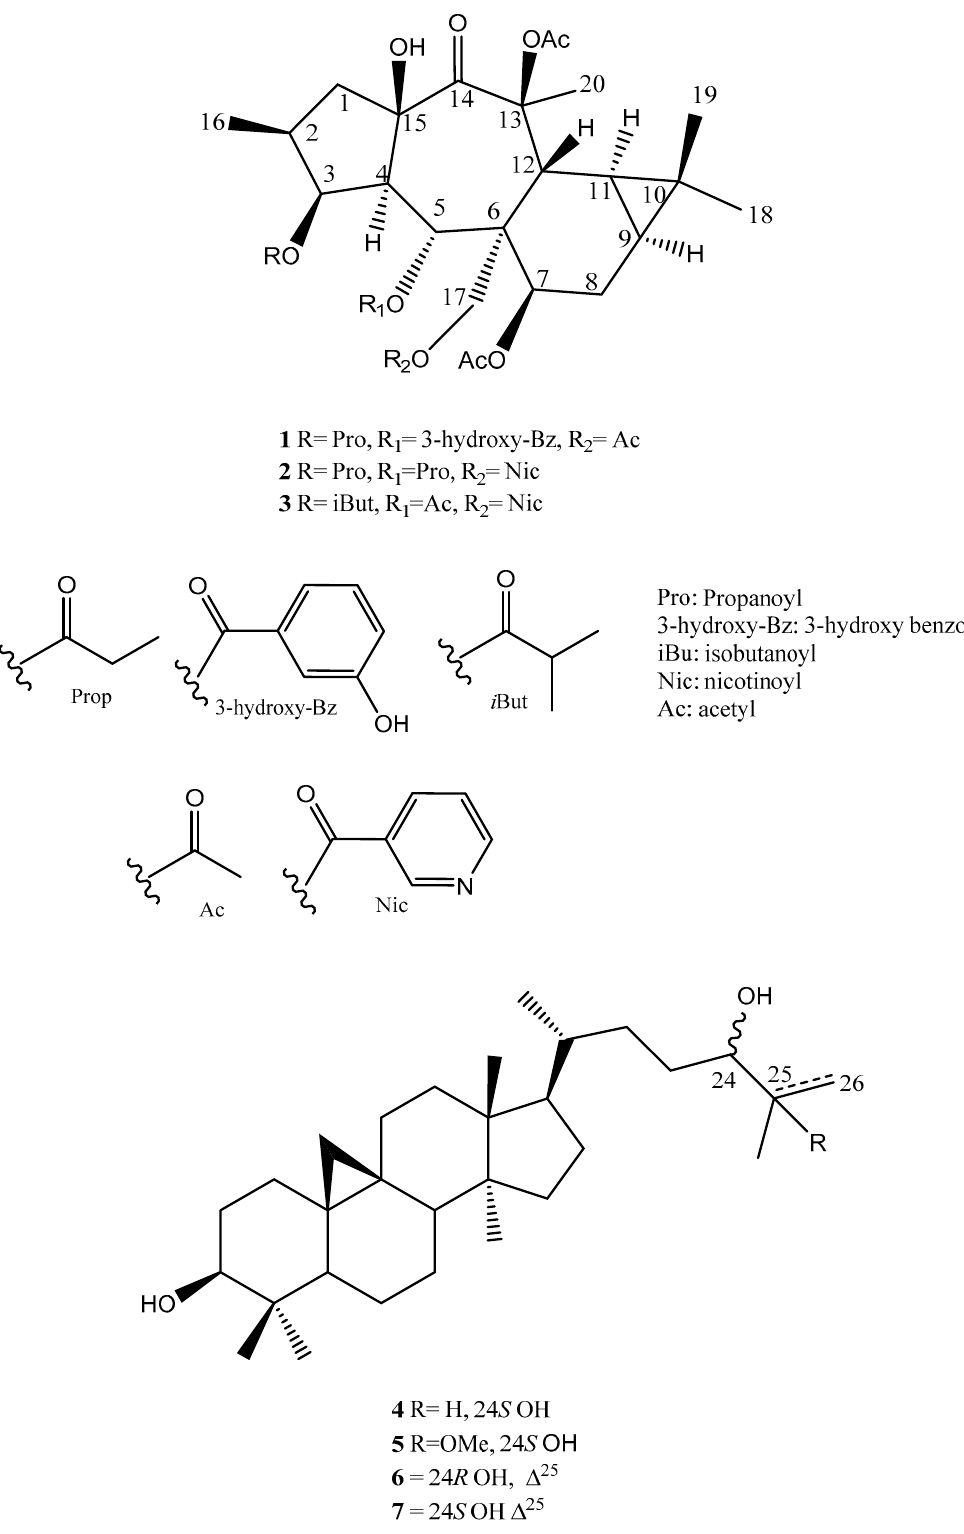
Figure 1. Isolated compounds from Euphorbia sanctae-catharinae .